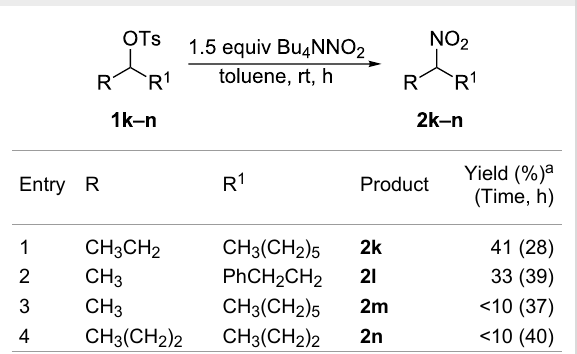
Table 3: Synthesis of secondary nitroalkanes 2k–n